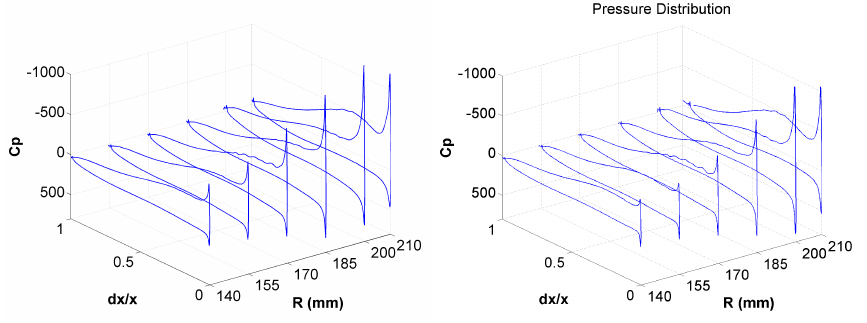
Figure 8. The pressure distribution at six constant radii.